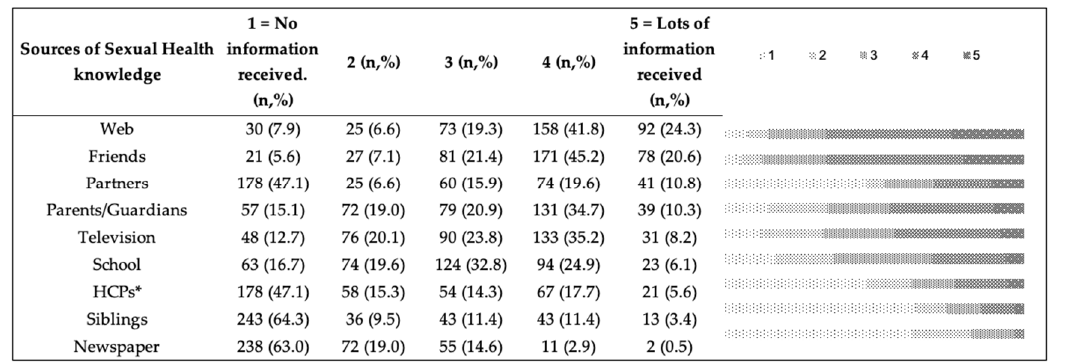
Figure 1. Sources of information chosen by high school students of the Metropolitan City of Bologna for SRH knowledge. * HCPs = Health Care Professionals.